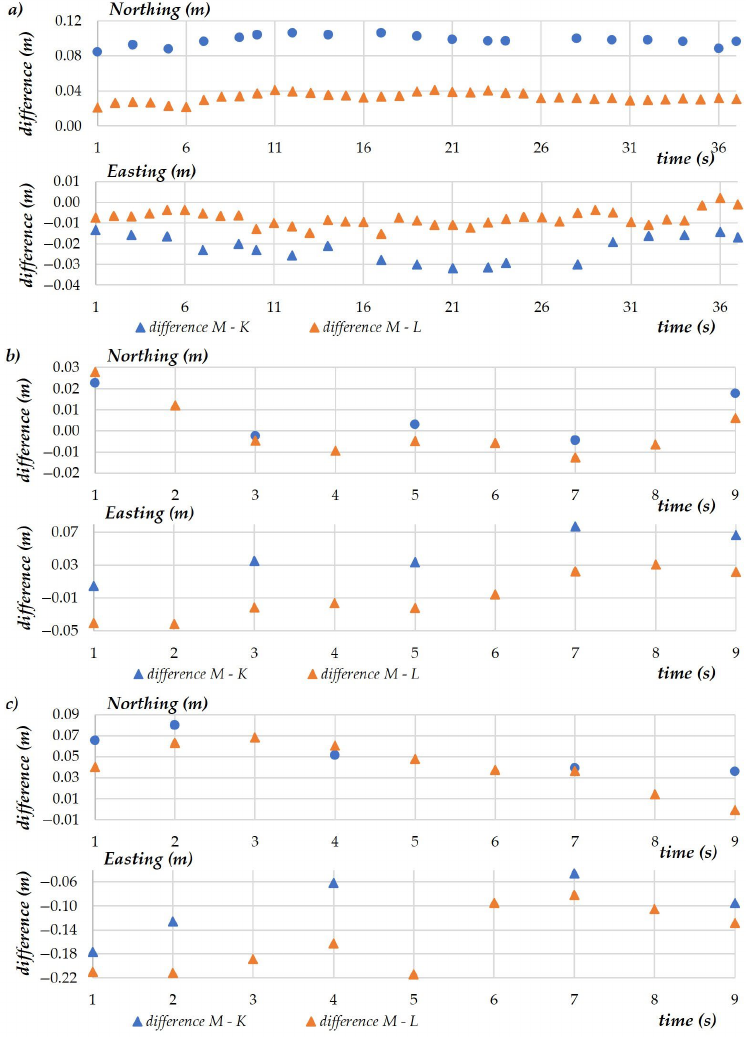
Figure 7. A comparison of the coordinates measured at each examined altitude ( a ) altitude H = 1.5 m;